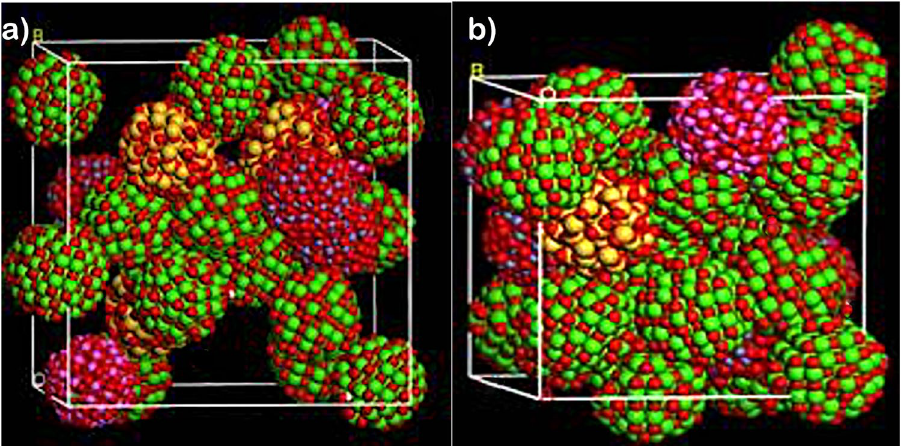
Fig. 13 a, b Molecular dynam- ics models of low pressure (PCLP), and high-pressure com- pacted Portland cement with particle fiber material